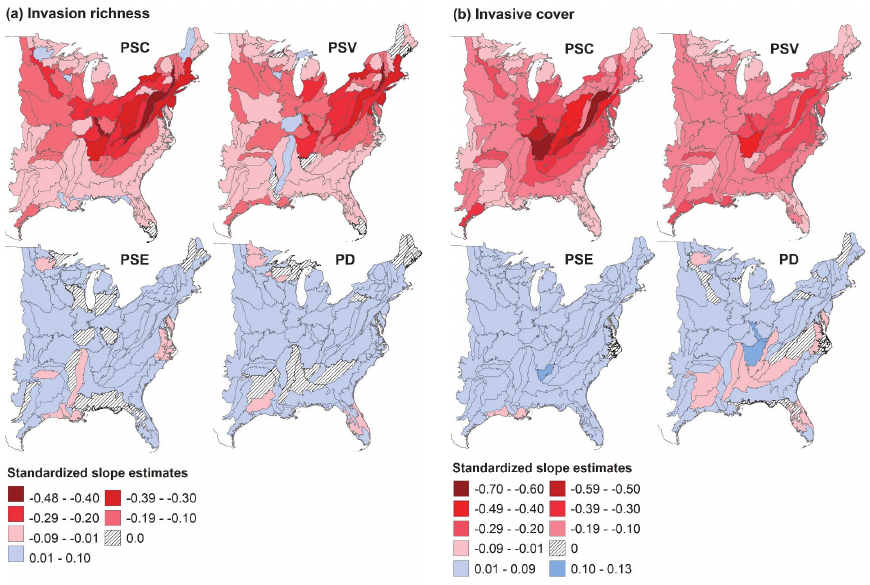
Figure 1. Standardised relationships between four metrics of evolutionary relatedness and invasive ( a ) richness and ( b )